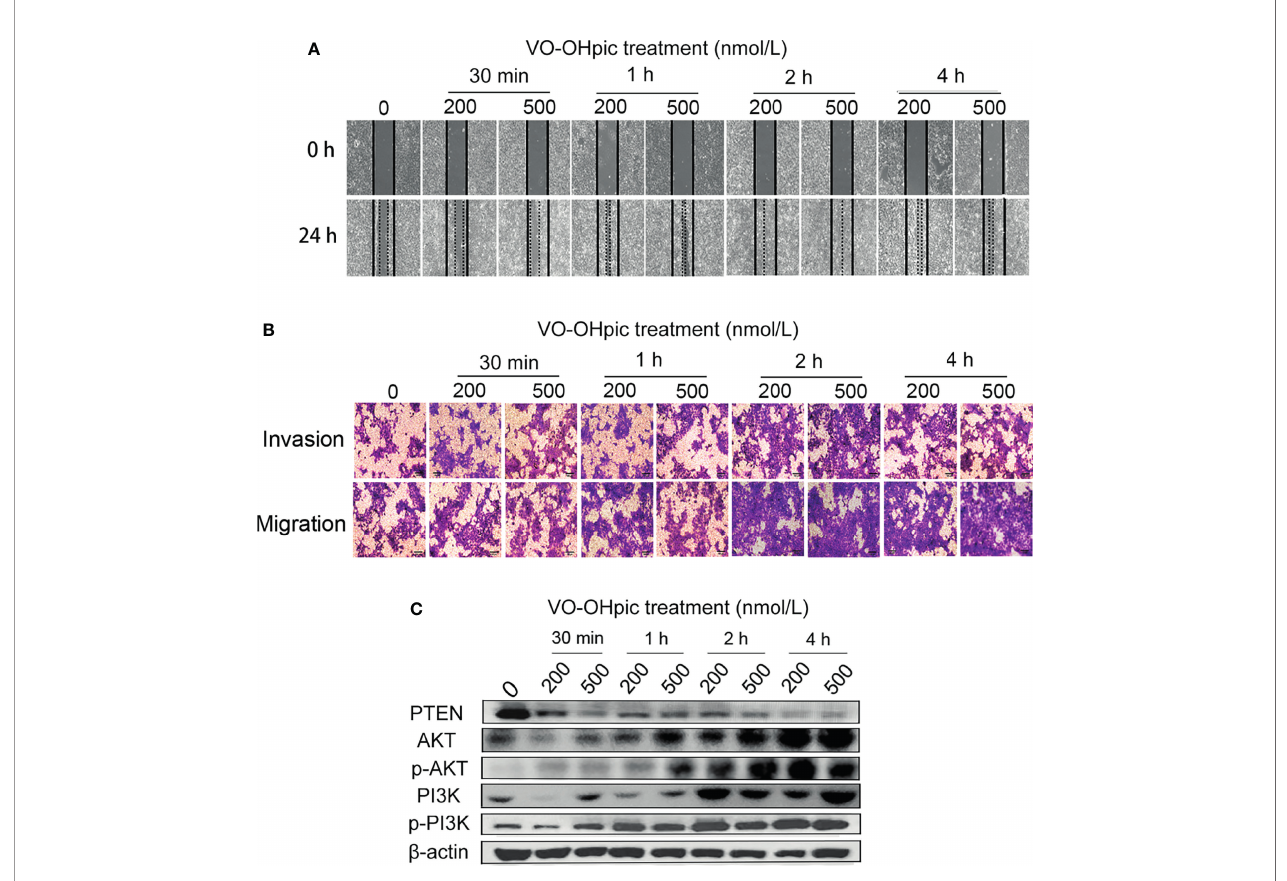
FIGURE 2 | Effect of inhibition of PTEN expression on migration and invasion of 4T1 cells. 4T1 cells were treated with 200 or 500 nmol/L VO-OHpic for 0.5 – 4 h and their migration and invasion abilities were then detected by cell scratch and transwell assays. (A) Cell scratch healing map. (B) Observation of cell migration and invasion by the transwell method (original magni fi cation, 100×), and effect of intracellular PTEN on cell proliferation activity (C)